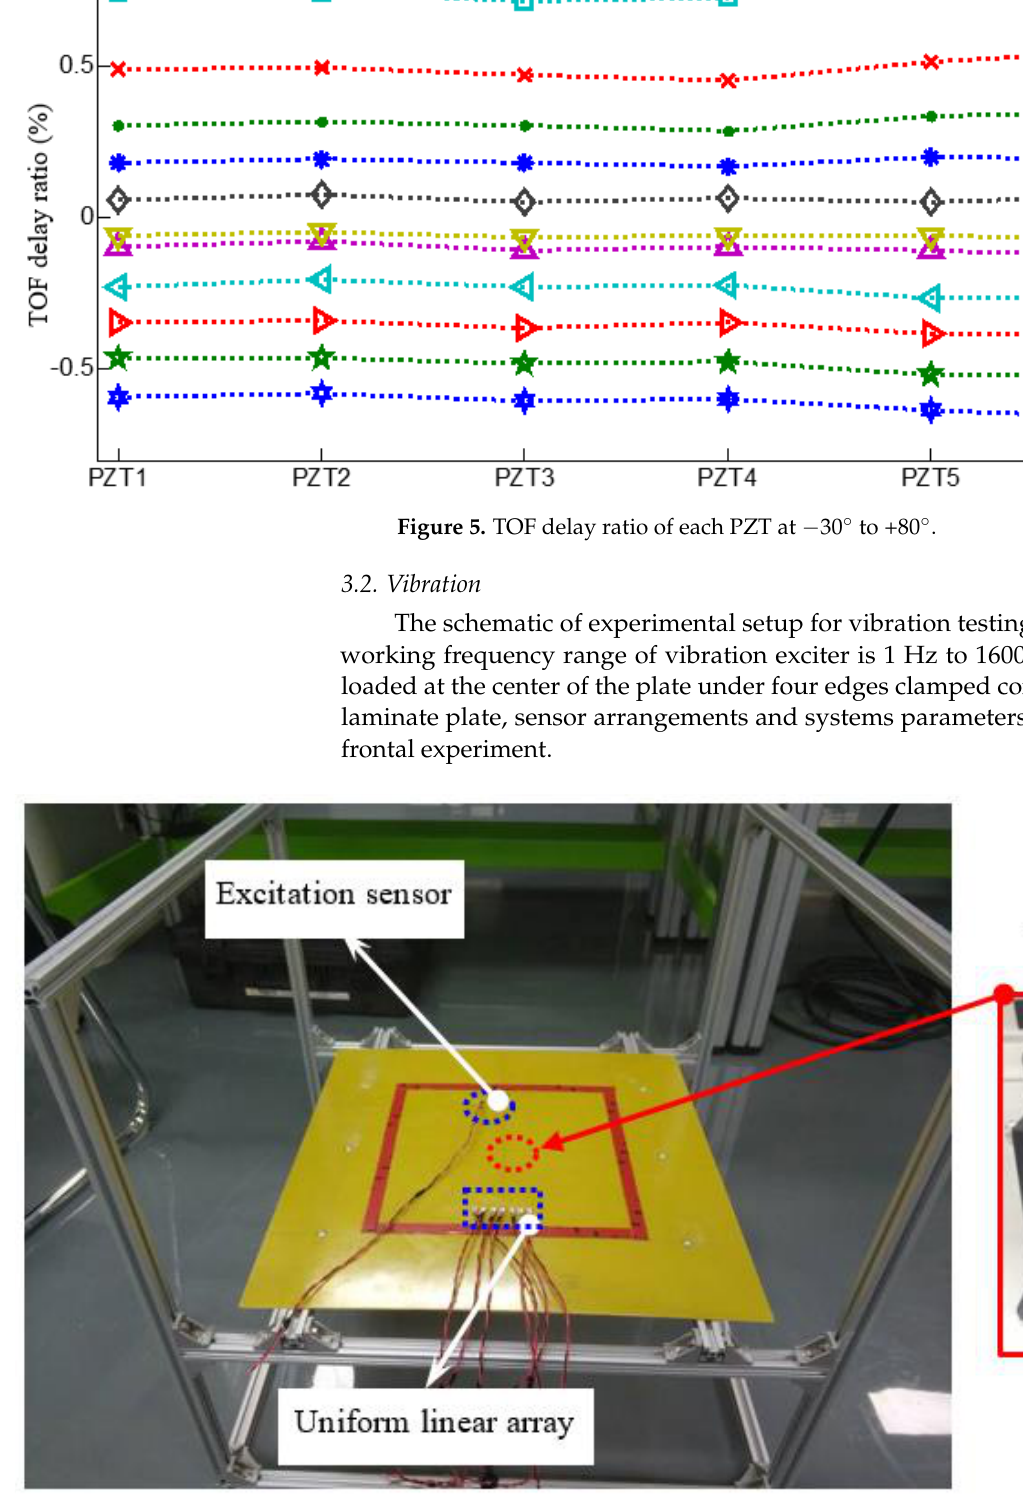
Figure 4. Experimental received Lamb wave array signal collection from −30° to 80°.